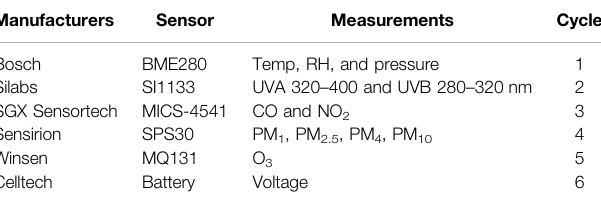
TABLE 1 | Manufacturers of the sensors components, their measurements and when they are used by the cycle